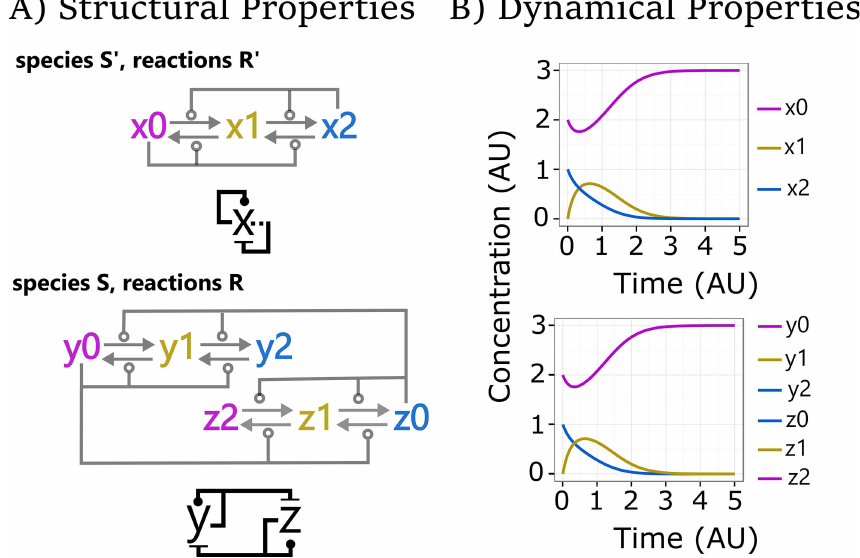
Fig 6. Network emulation. Condensed and extendedwiringdiagramsof AM (above) and MI (below) and their deterministic behaviour in time-coursediagrams. A morphism m :(S,R) ! (S’,R’) betweentwo reaction networks(S,R) and (S’,R’) is a mappingof species S (e.g., y 0 , y 1 , y 2, z 0 , z 1 , z 2 of MI) to species S’ (e.g., x 0 , x 1 , x 2 of AM, by corresponding colours) and of reactions R to reactions R’. Structural properties: A morphism that preserves the reactants and products of each reaction under the mappingis calleda homomorphism. One that preserves stoichiometry under the mapping(by appropriately summing multiplicities and rates) is called a stoichiomorphism. These propertiescan be calculateddirectly on the network representation. Dynamical properties: A morphism m is an emulationif it preserves all trajectoriesof species concentrations over time under the mapping(e.g., the trajectories on the right are preserved). That is, m is an emulationif for any choice of initial conditions I’ for S’ there exist initial conditionsI for S such that the trajectory of each species s in S overlapsexactly the trajectory of m (s) in S’. Theorem [44]: A morphismthat is a homomorphism and a stoichiomorphism is also an